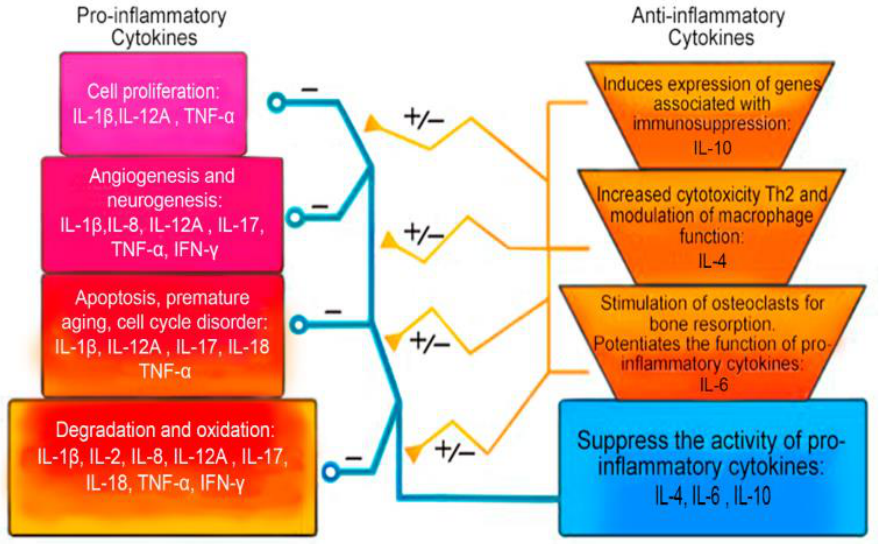
Figure 3. Mechanisms for modulating the effects of pro-inflammatory cytokines by anti-inflammatory cytokines in intervertebral disk degeneration. Note: IL—interleukin; TNF- α —tumor necrosis factor-alpha, IFN- γ —interferon-gamma; ( − )—suppression of pro-inflammation cytokines effect; (+/ − )— modulation of pro-inflammation cytokines effect.